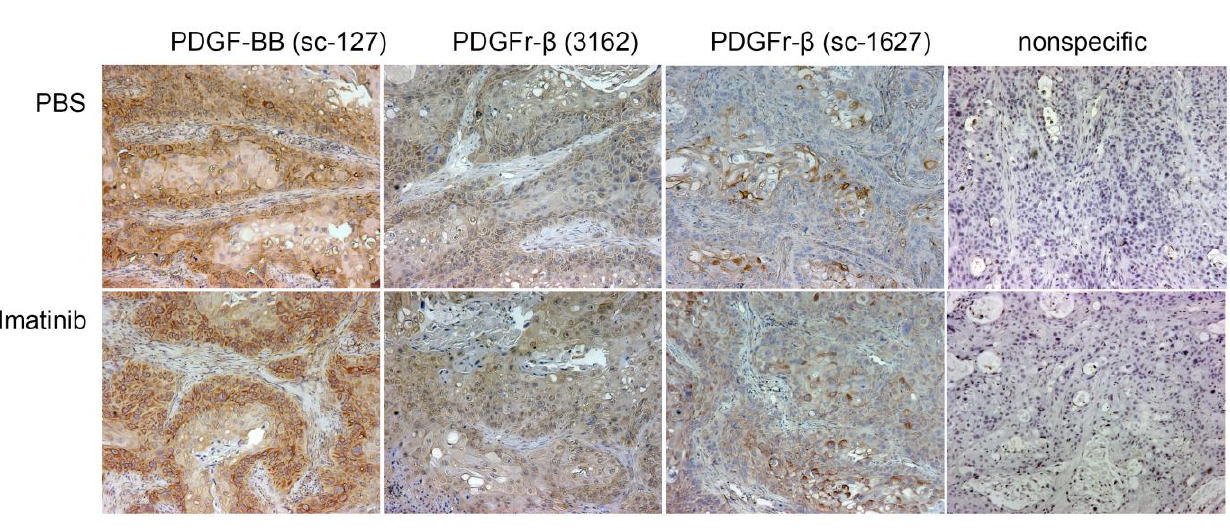
Figure 5. Immunohistochemistry of PDGF-B and PDGFr-β in xenografts extirpated from PBS- and imatinib-treated mice. Original magnification 10  , counterstained with